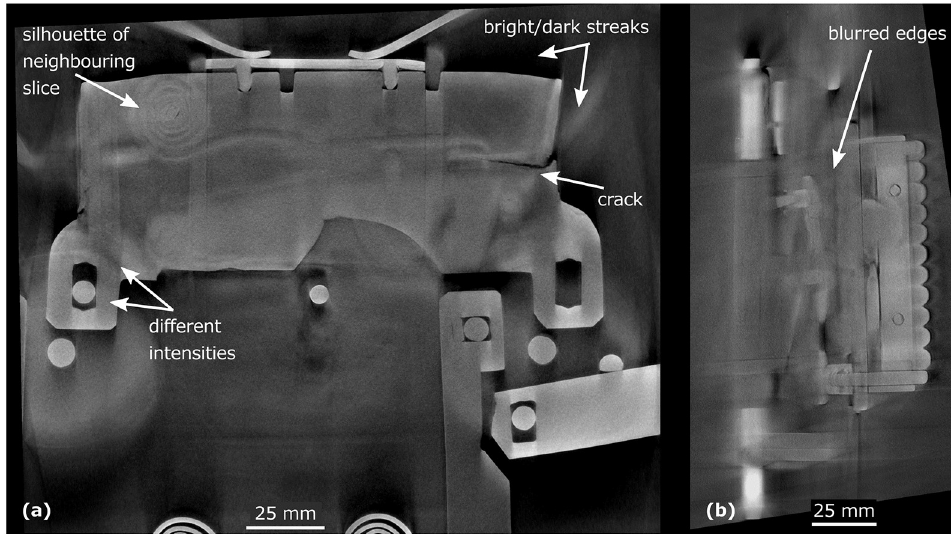
Fig 3. Selected transverse (a) and longitudinal (b)